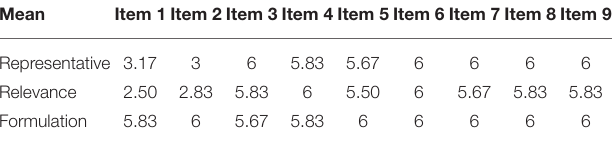
TABLE 6 | Mean (students-post).